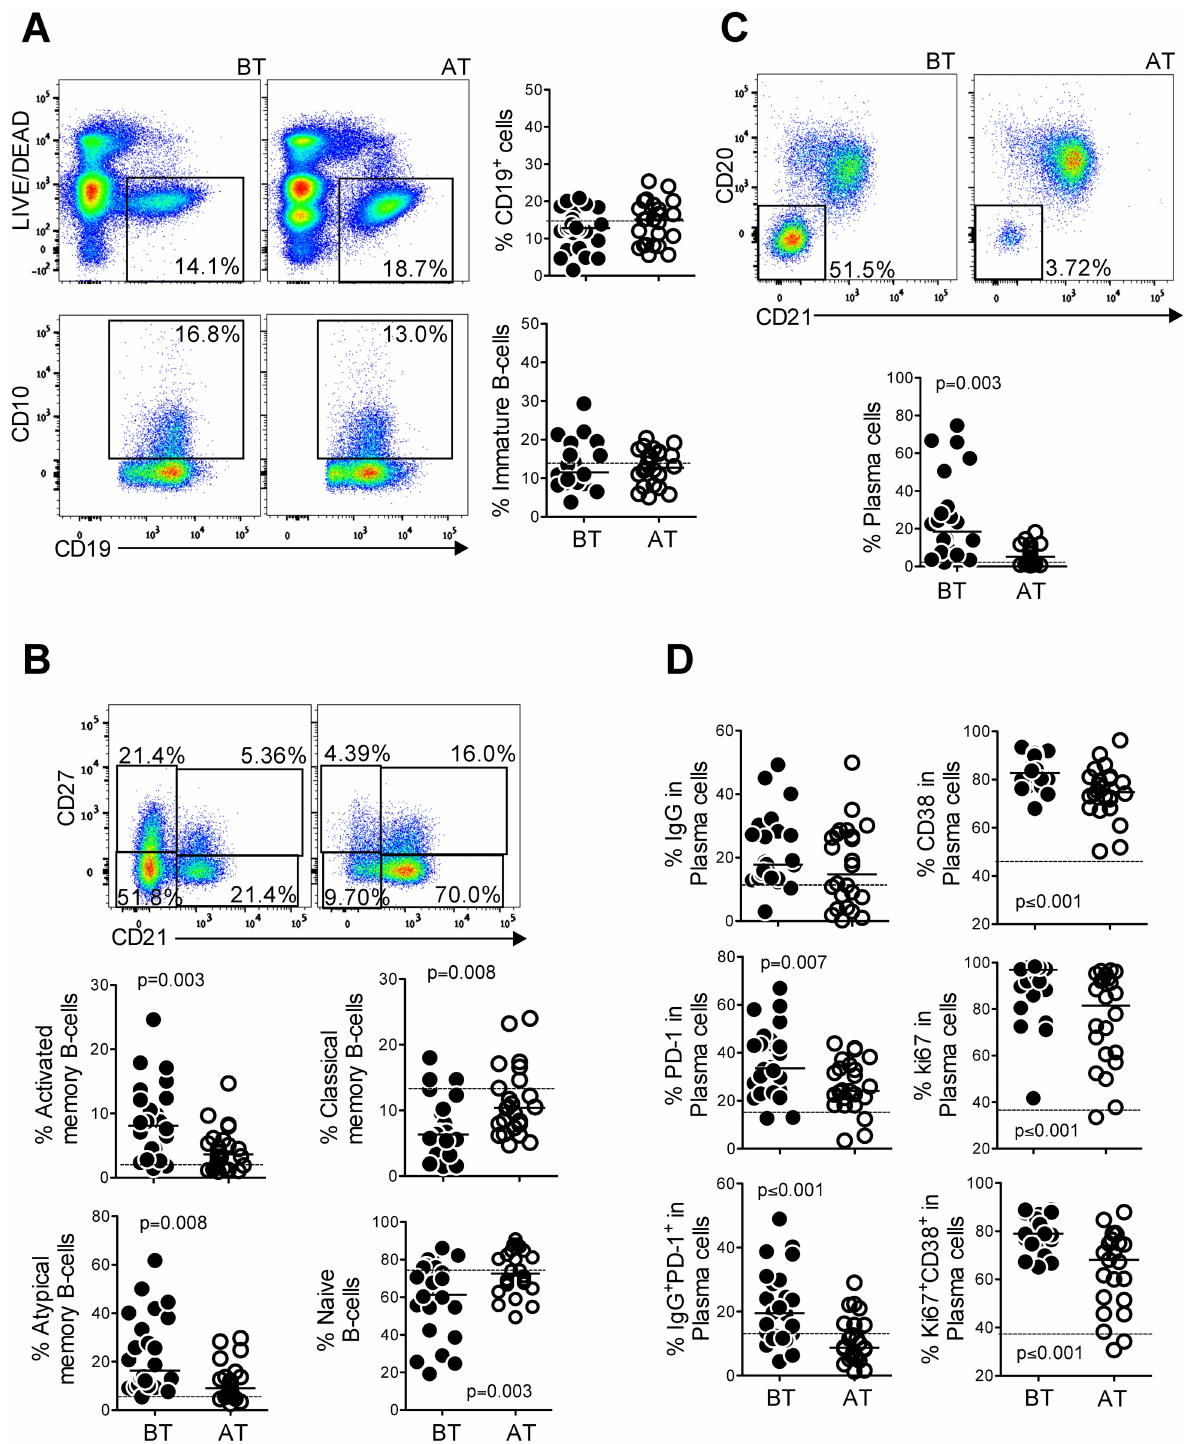
Fig 5. Proportions of B cell subsets are altered during Plasmodium vivax infection. PBMC from P . vivax -infected patients were analyzedex vivo (n = 24) duringacute malaria episode(BT) and 30–45days after treatment (AT). All the B cell subsets were analyzed after gatingon live CD19 + cells. A . Representative density plots showingfrequencyof total B cells (CD19 + cells), immature (CD10 + ) B cells from a single P . vivax -infectedpatient and scattered plots showingthe proportions of total B cells (CD19 + cells) and immature (CD10 + ) B cells. B. Representative density plots showing frequency of activated memory (CD27 + CD21 - ), classical memory